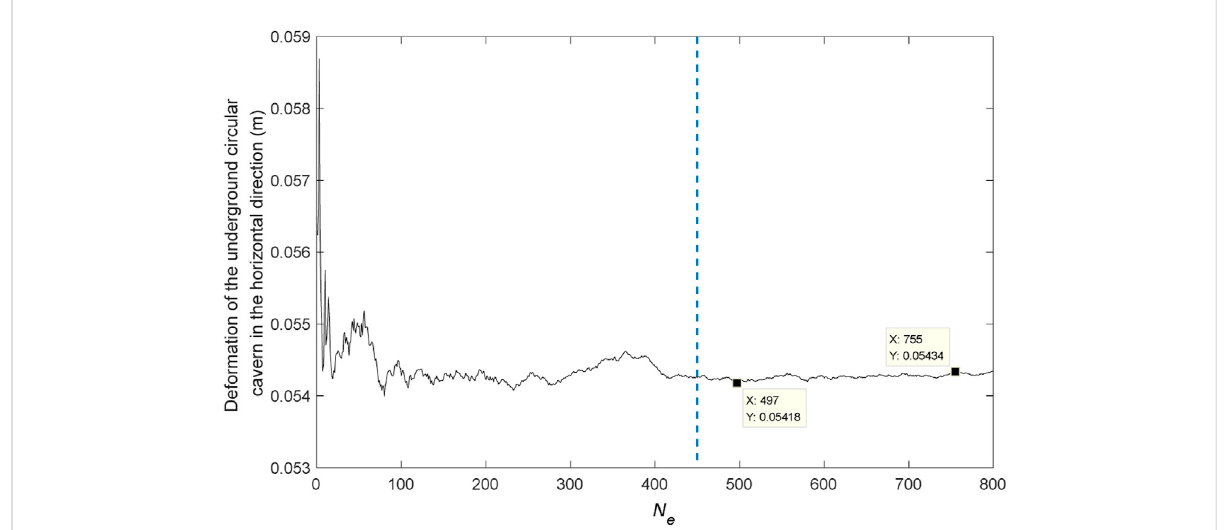
FIGURE 4 The change of horizontal displacement with the number of simulation